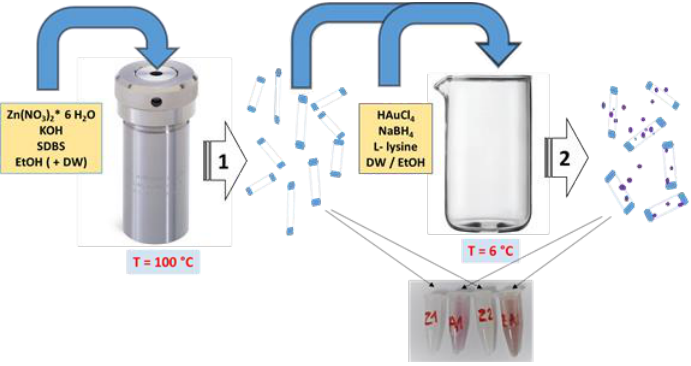
Figure 1. Flow chart of of ZnO and ZnO/Au